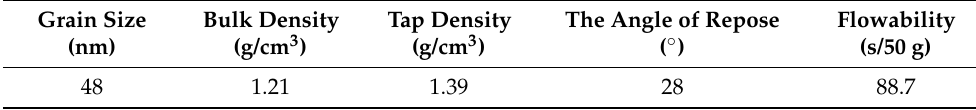
Table 5. Properties of flame spheroidized mullite powders.